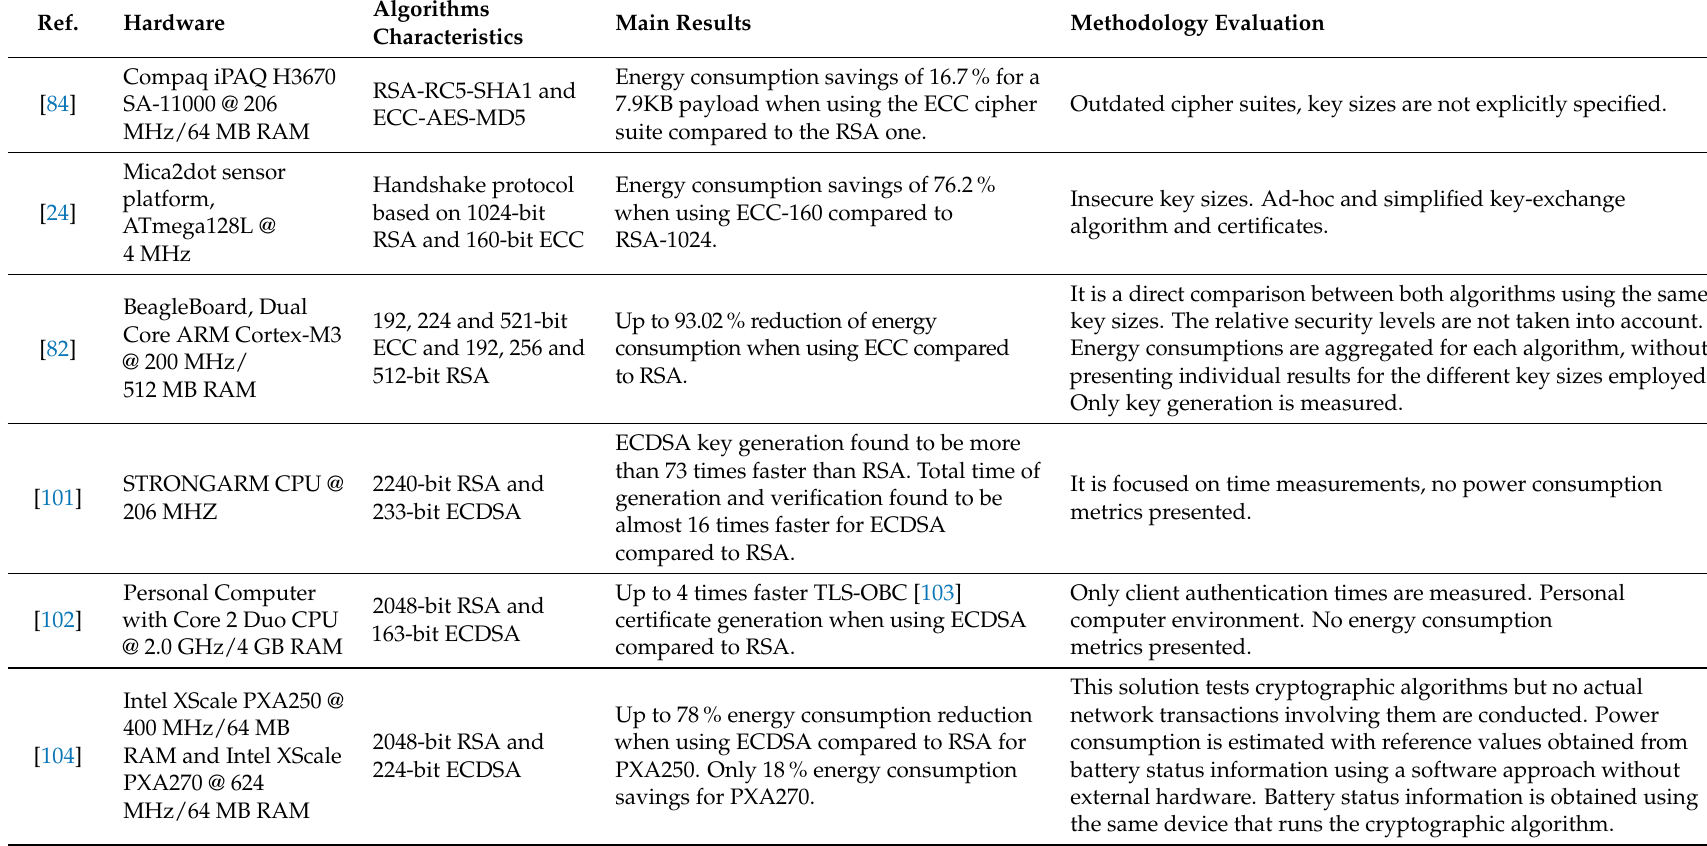
Table 7. Analysis of the main RSA and ECC comparisons